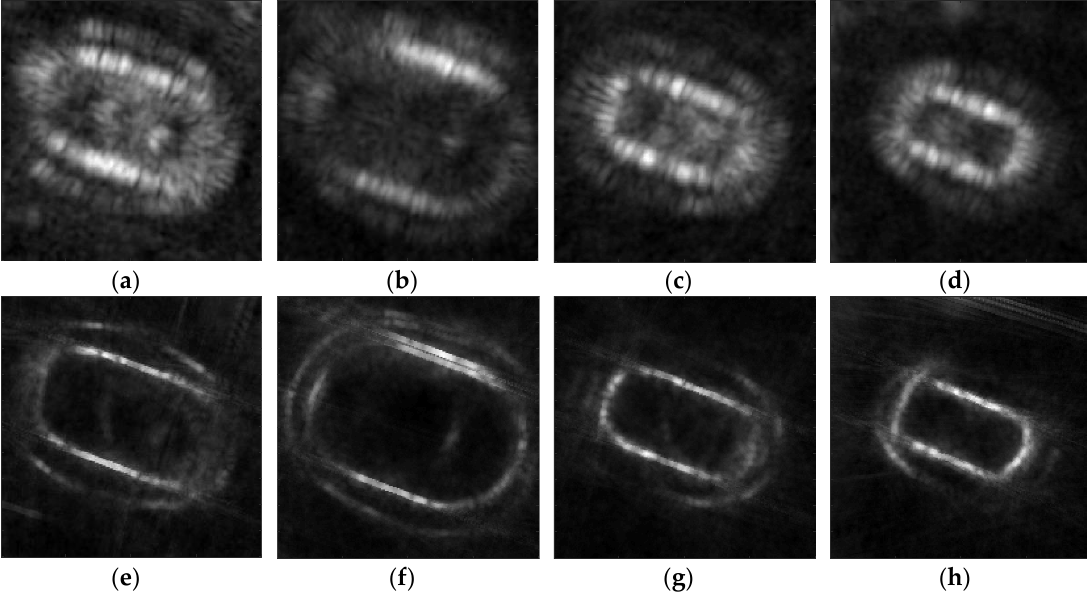
Figure 9. Imaging results of different models of vehicle targets in the Gotcha dataset by piecewise linear transformation: ( a , e ) Chevrolet Impala LT; ( b , f ) Mitsubishi Galant ES; ( c , g ) Toyota Highlander; ( d , h ) Chevrolet HHR LT.